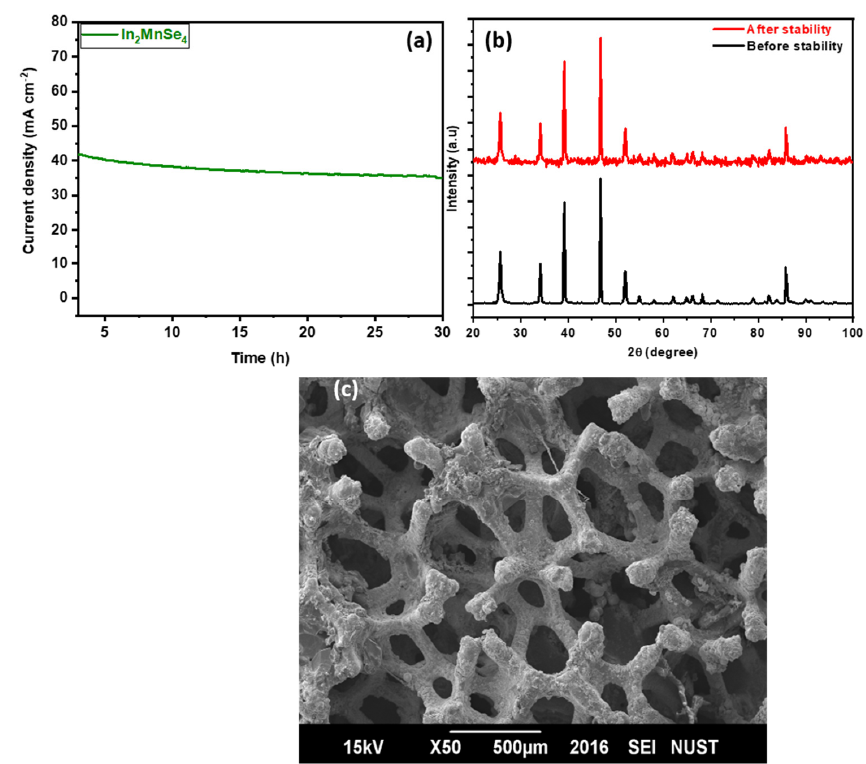
Figure 8. ( a ) I–t curve measurement for ln 2 MnSe 4 nanostructure, XRD pattern, SEM micrograph before and after stability. ( b ) XRD patterns of samples before and after stability. ( c ) SEM foto of ln 2 MnSe 4 nanostructure.